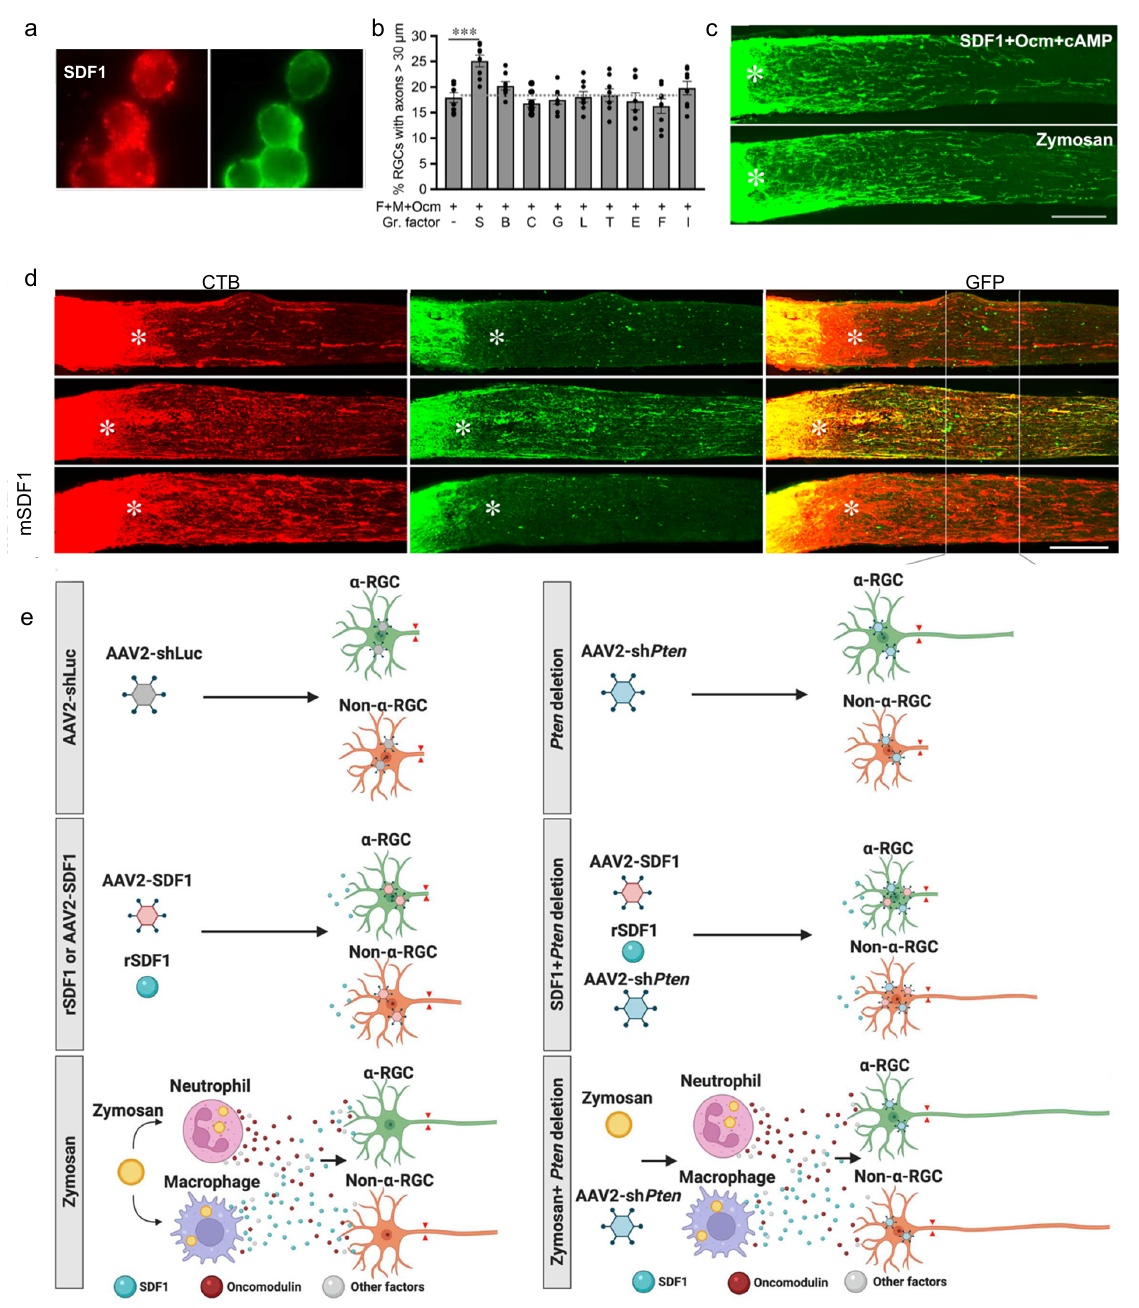
Figure 2. Macrophage-derived SDF1 complements the effects of Ocm (previous page). ( a ) SDF1 (red) is highly expressed in F4/80 macrophages that infiltrate the vitreous by 24 h after intraocular injection of Zymosan. ( b ) Among multiple trophic factors tested in dissociated adult retinal cell cultures, SDF1 is the only factor that enhances the effects of Ocm (combined with co-factors mannose and CPT-cAMP). B: Brain-derived neurotrophic factor (BDNF); C: ciliary neurotrophic factor (CNTF); G: glial cell-derived trophic factor (GDNF); L: leukemia inhibitory factor (LIF); T: tumor-necrosis factor (TNF); F: fibroblast growth factor-2; I: insulin-like growth factor 2 (IGF2). *** p < 0.001. ( c ) SDF1 combined with Ocm and CPT-cAMP induces similar levels of regeneration as Zymosan. ( d ) SDF1 alters the response of different RGC populations to PTEN deletion. aRGCs, the population that ex- tends axons in response to Pten deletion, are identified by virtue of expressing GFP from the Kcng4 promoter. Axons arising from all RGCs, whether aRGCs or non-aRGCs, are labeled with CTB. Top row: In response to SDF1 alone, regenerating GFP-negative axons all arise from non-aRGCs. Middle